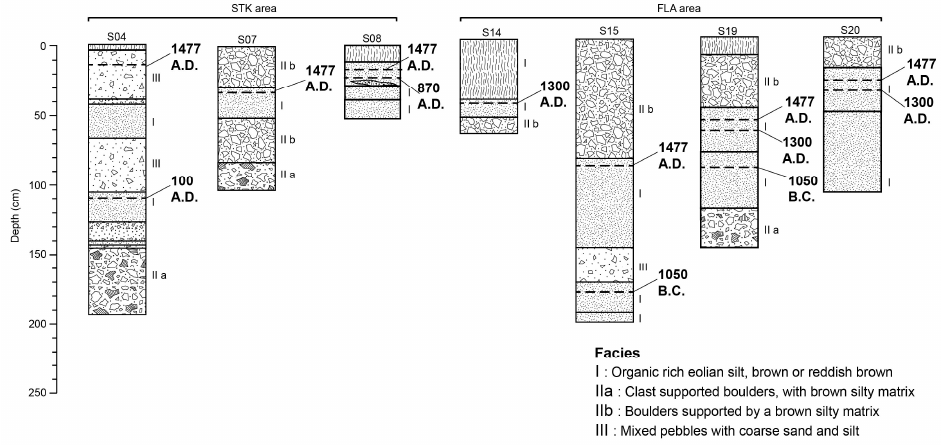
Figure 7. Synthesis of stratigraphical profiles showing alternating phases of stability (Facies I) and activity (Facies II, III, IV) in Flautafell, Northeast Iceland. For cross ‐ section localization, see Figure